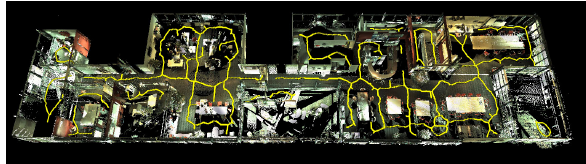
Figure 10. Geometrical network model overlaid into point